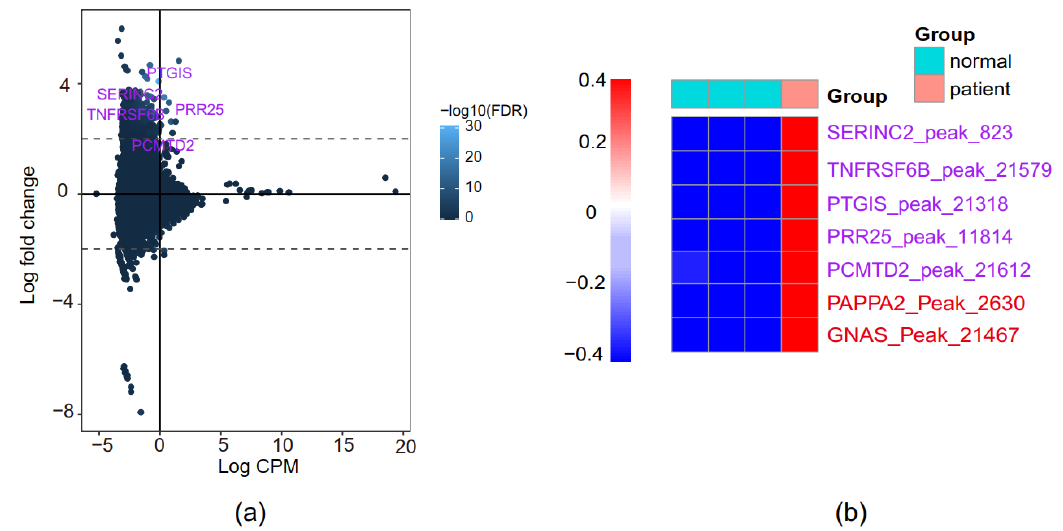
Figure 4. Identification of novel PE-associated genes ( a ) The M-versus-A plot (MA plot) of peaks. ( b ) Heatmap of possible PE-associated genes.